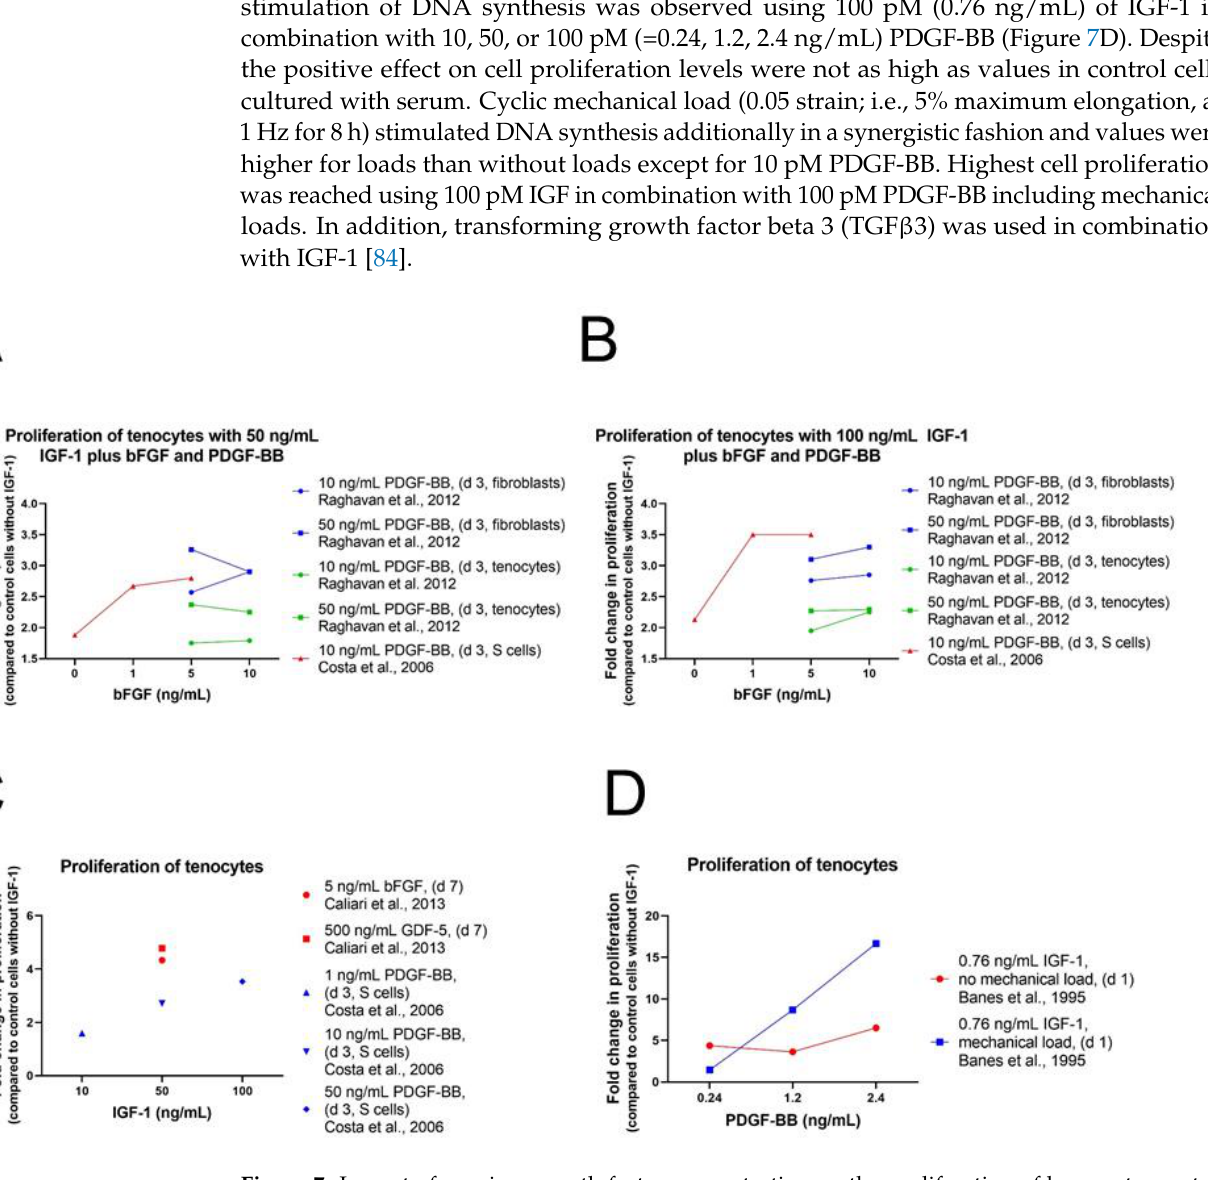
Figure 7. Impact of varying growth factor concentration on the proliferation of human tenocytes, cultivated in Ham’s F12 containing 0.2% BSA [77]; varying bFGF concentration in the presence of 50 ng/mL IGF-1 [81] ( A ) or 100 ng/mL IGF-1 [81] ( B ); varying IGF-1 concentration in the presence of several other growth factors [81,82] ( C ) and varying PDGF-BB concentrations in the presence of 0.76 ng/mL IGF-1 with and without mechanical loading ( D ) [13].